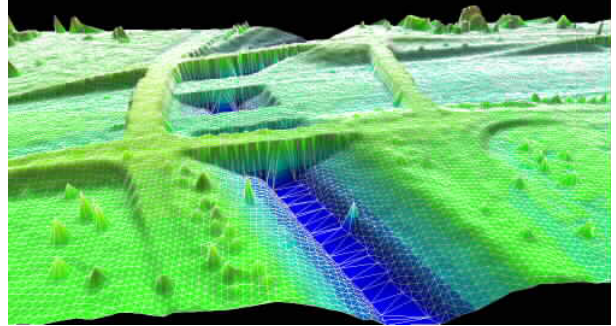
Figure 6. The micro-topography information for the digital eleva- tion model